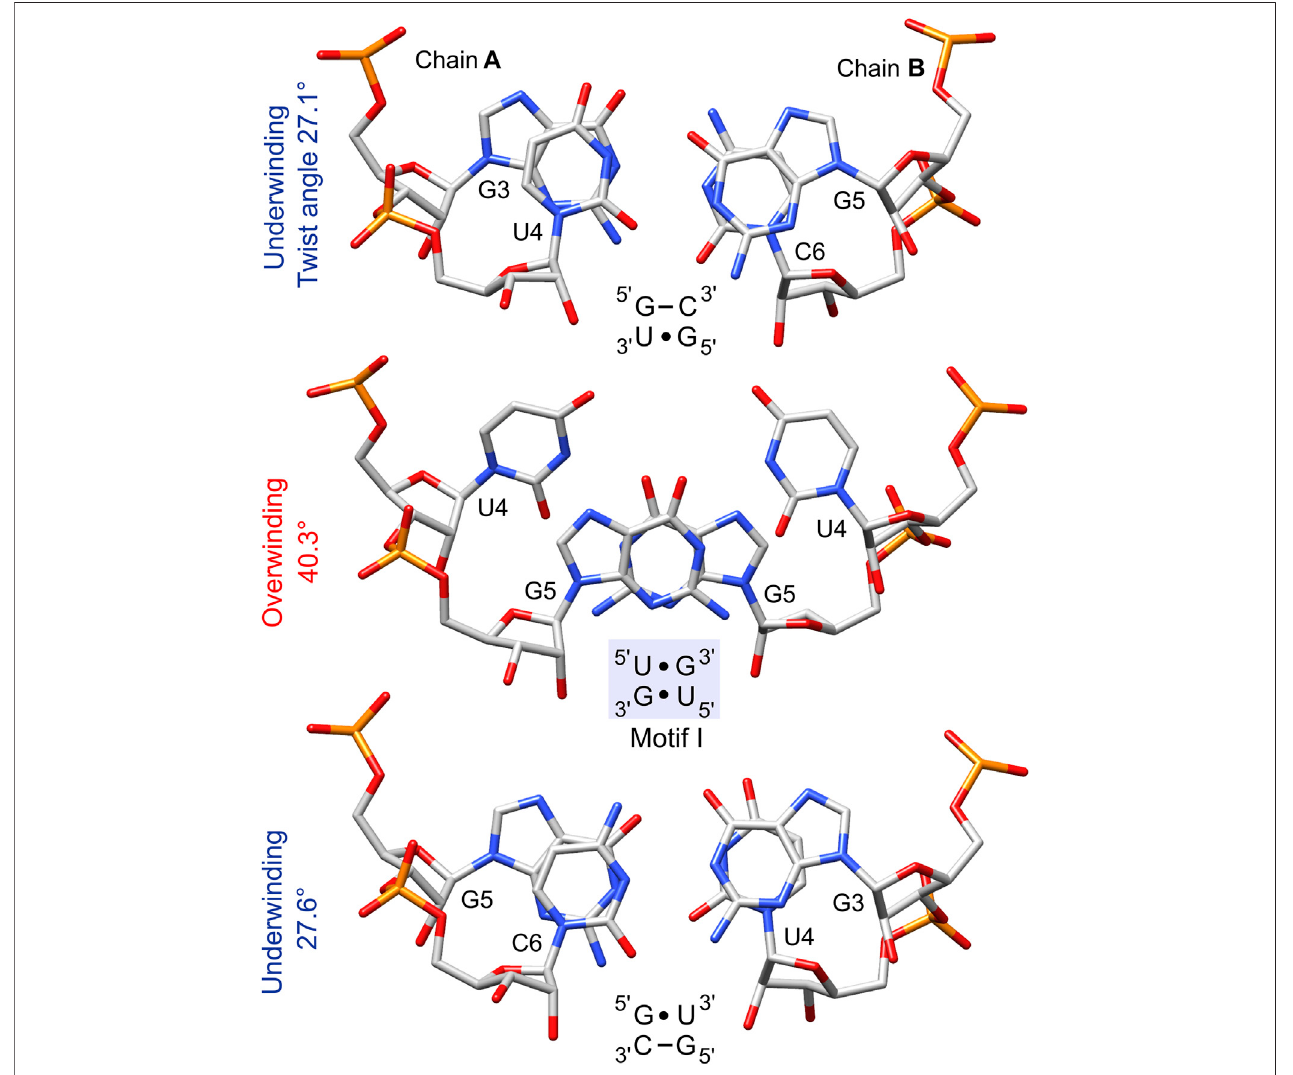
FIGURE 7 | The stacking pattern within the 5 ′ UG/3 ′ GU tandem and between the wobble tandem pairs and fl anking GC pairs. The 5 ′ UG/3 ′ GU wobble tandem represents motif I ( light blue box ), in which inter-strand stacking involves rings of guanosines, whereas unstacked uracils face each other. Local twist angle variations associated with each step are